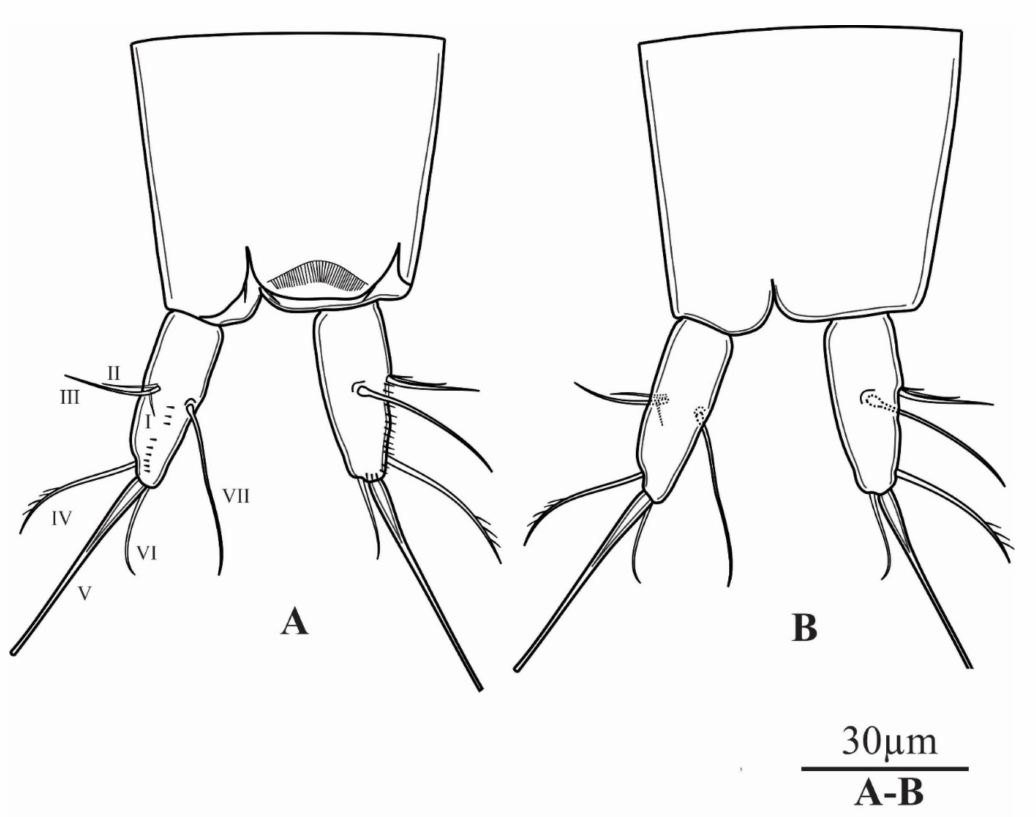
Figure 2. Parastenocaris sontraensis sp. nov. holotype female. ( A ), anal somite with furcal rami dorsal view; ( B ), anal somite with furcal rami ventral